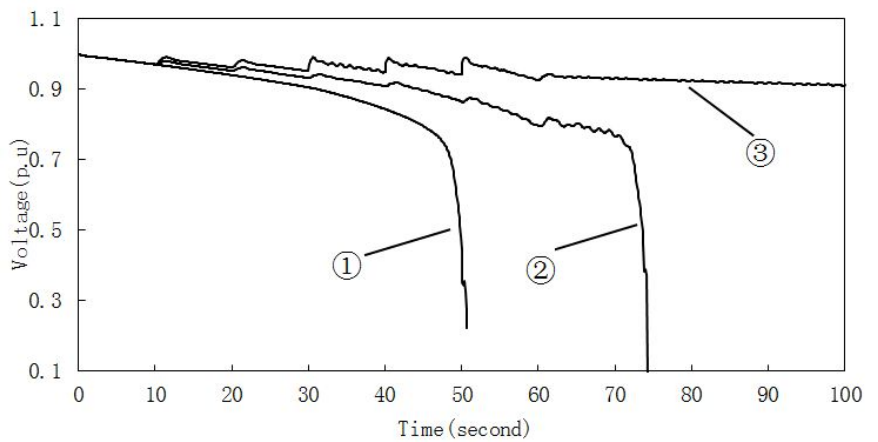
Figure 5. Voltage curve of key bus 16.